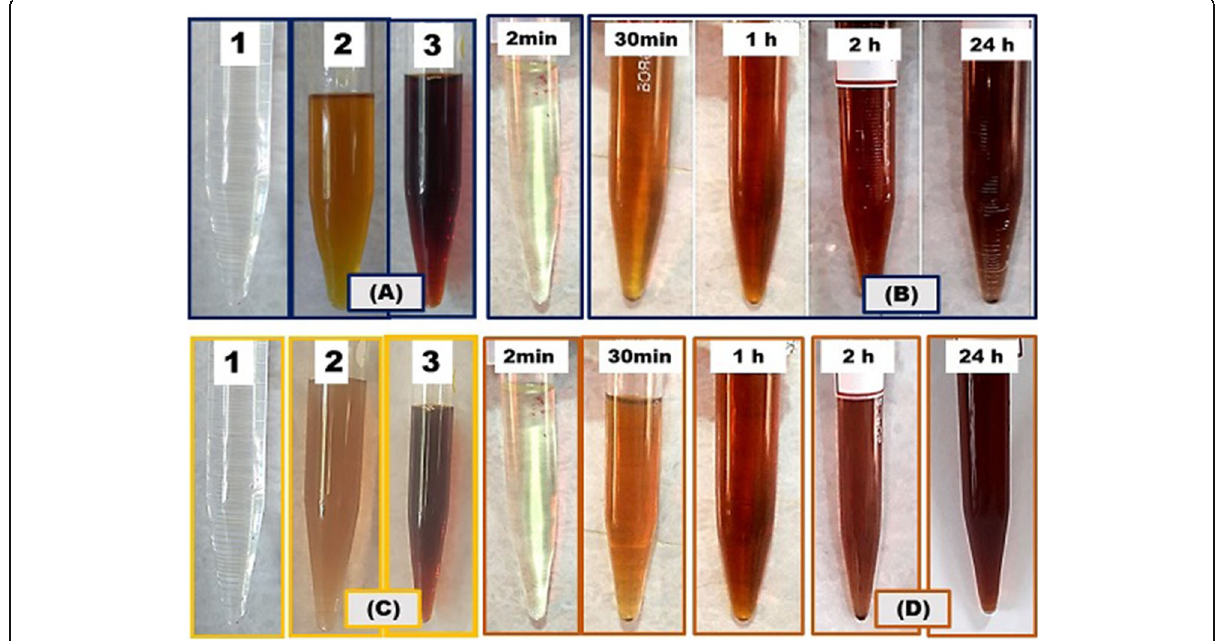
Fig. 2 a (1) AgNO 3 solution (2) CP leaf extract (3) Synthesized AgNPs. b Showing color intensity of CP leaf extract after time intervals of 2 min, 30 min, 1 h, 2 h, and 24 h. c (1) AgNO 3 solution (2) CP callus extract (3) synthesized AgNPs. d Showing color intensity of CP callus extract after